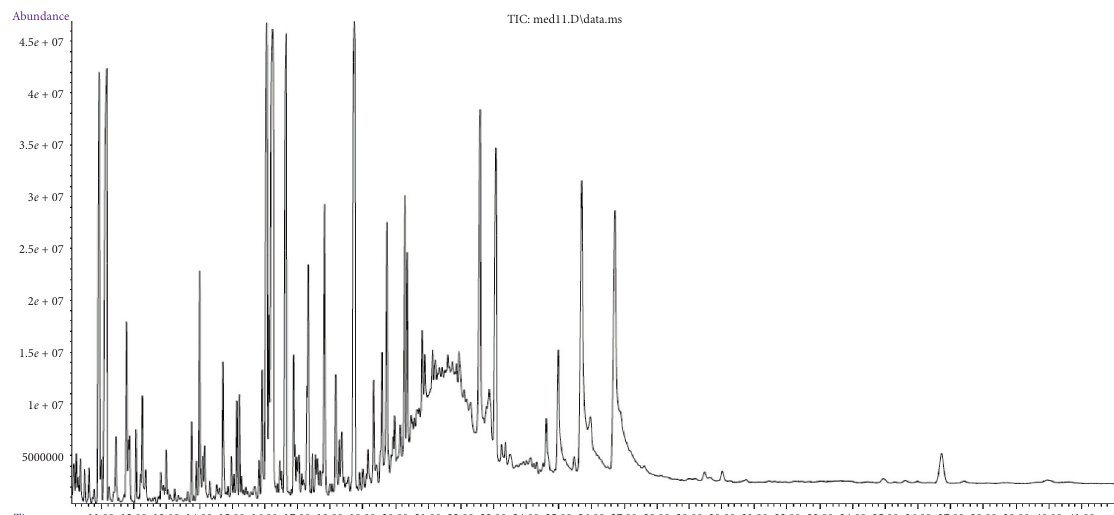
Figure 2: The analysis chromatogram of the Lavatera thuringiaca L subcritical SP